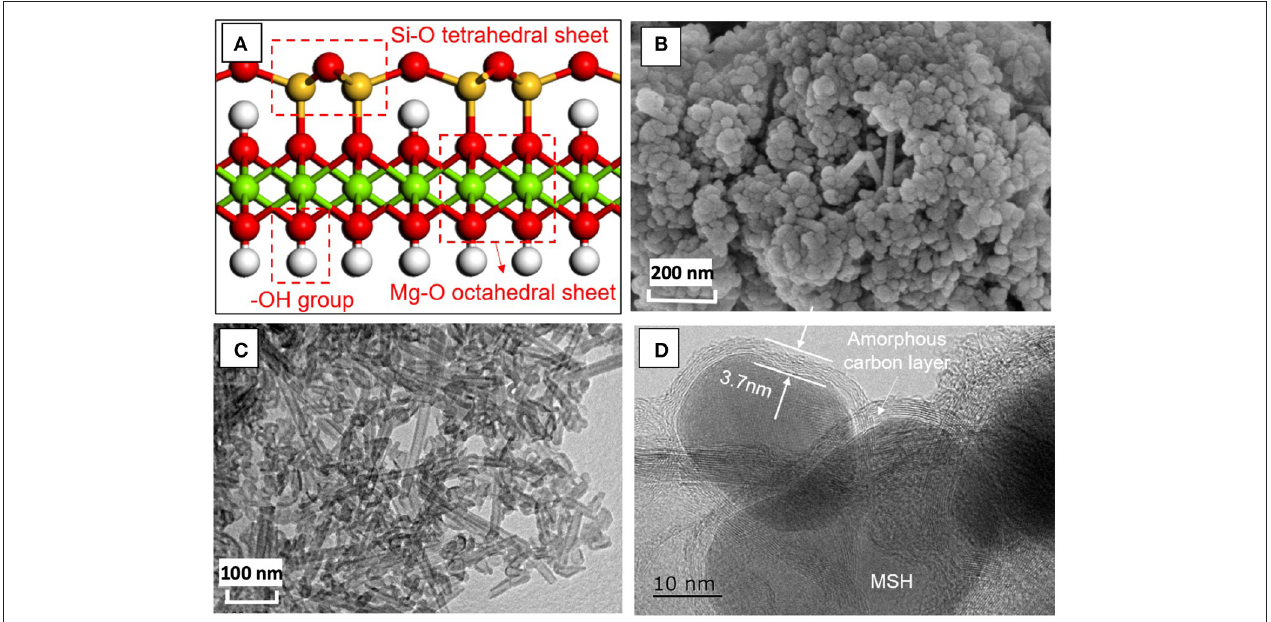
FIGURE 2 | The diagram of the film preparation process: (a) antimony oxide powder is first used to create (b) a uniform adhesion layer that is then covered with (c) the MSH/C powder-based film. (d) SEM image indicates uniform coverage of the final sample surface.